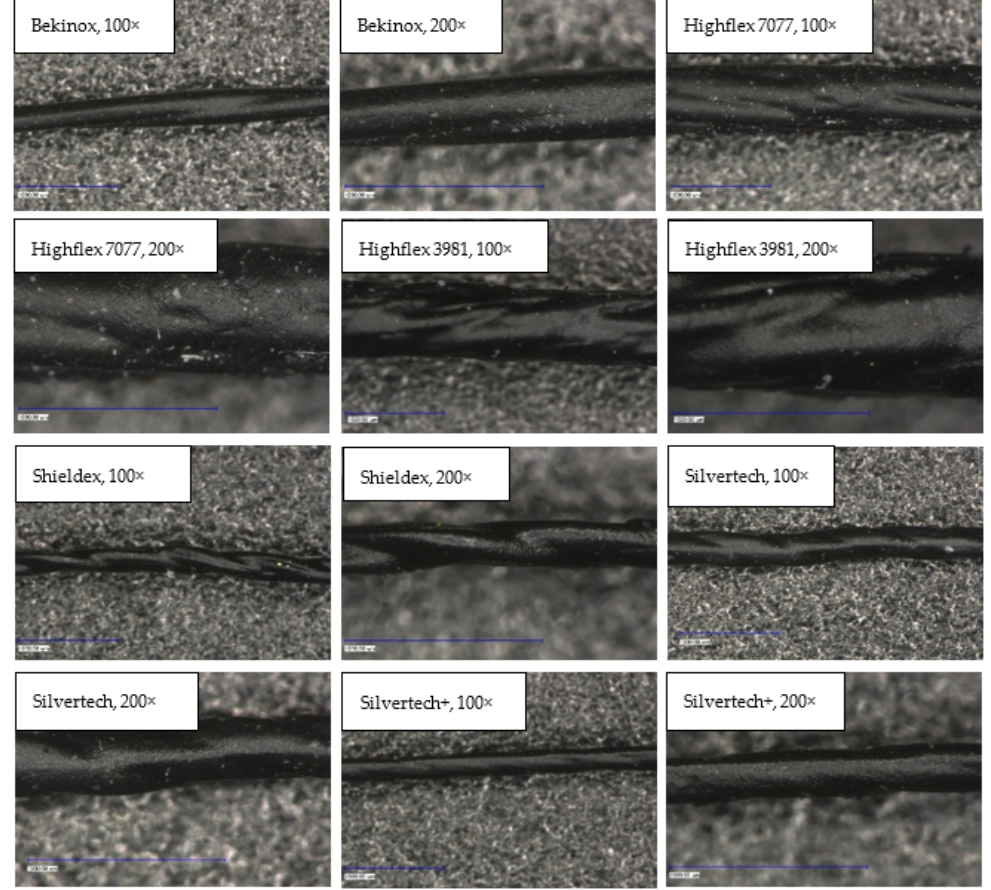
Figure 6. Light microscopic images of coated yarns.